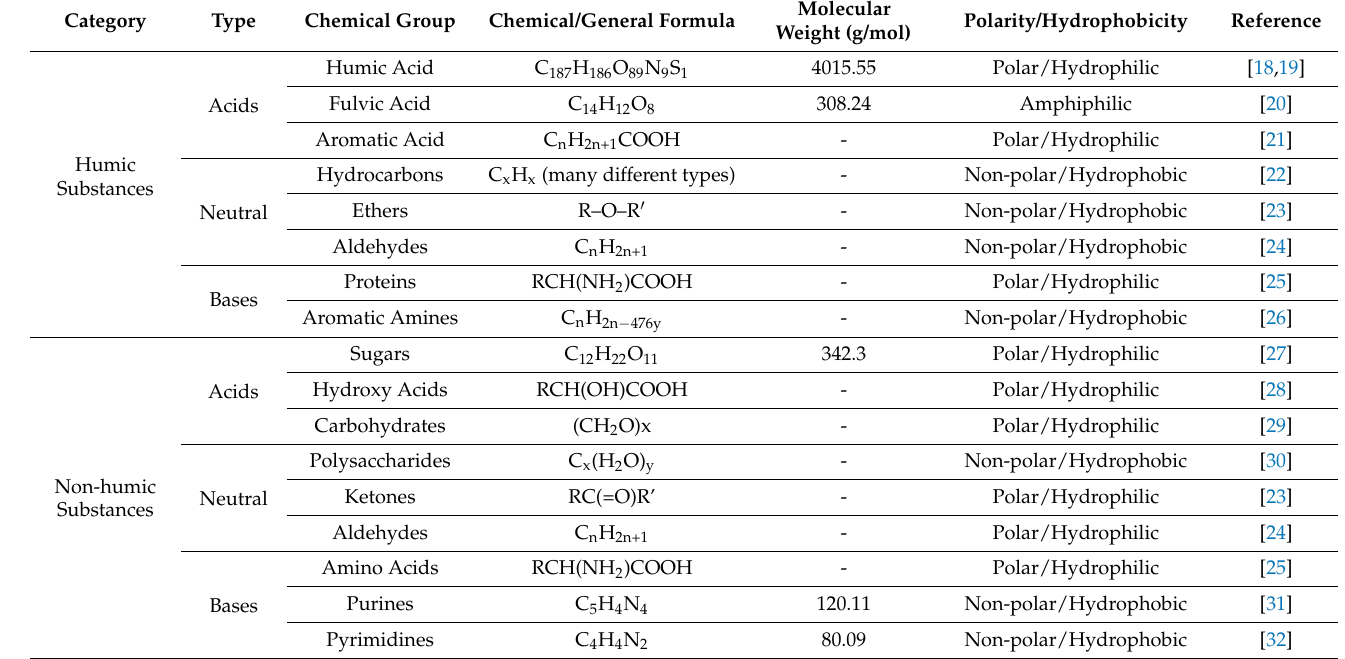
Table 2. Classifications and characteristics of natural organic matter that are commonly found in agricultural